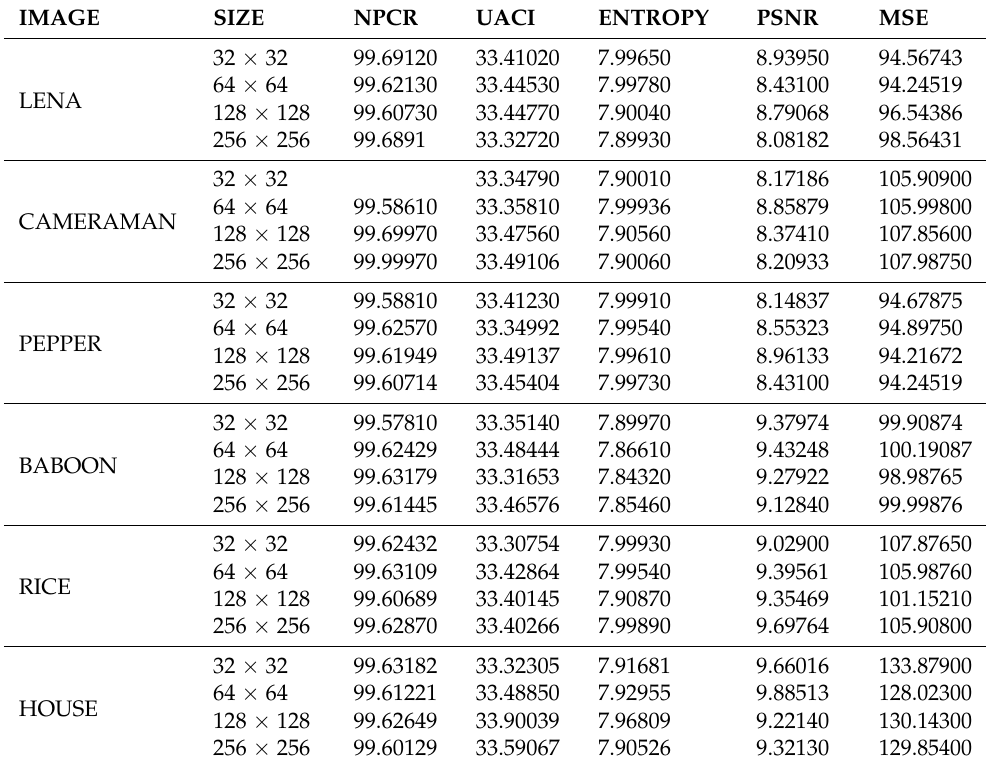
Table A1. Sample